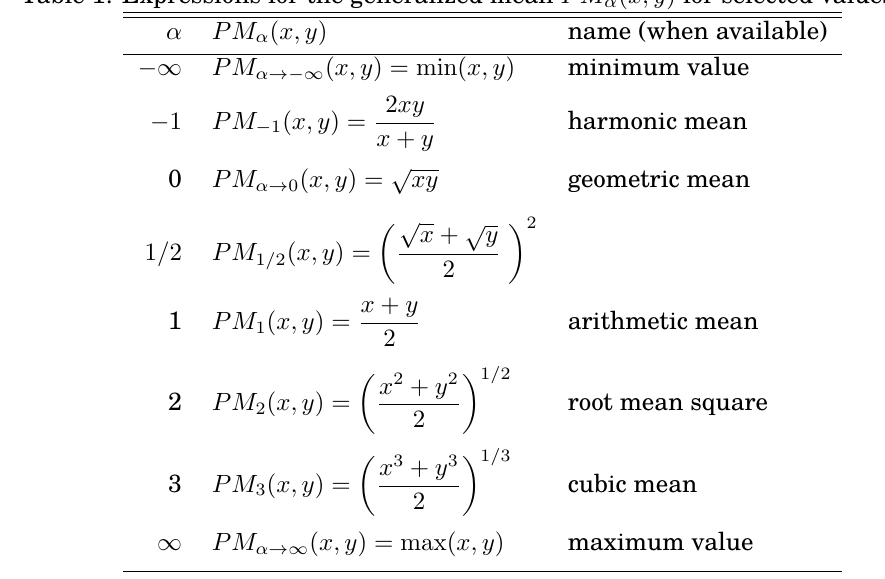
Table 1: Expressions for the generalized mean PM